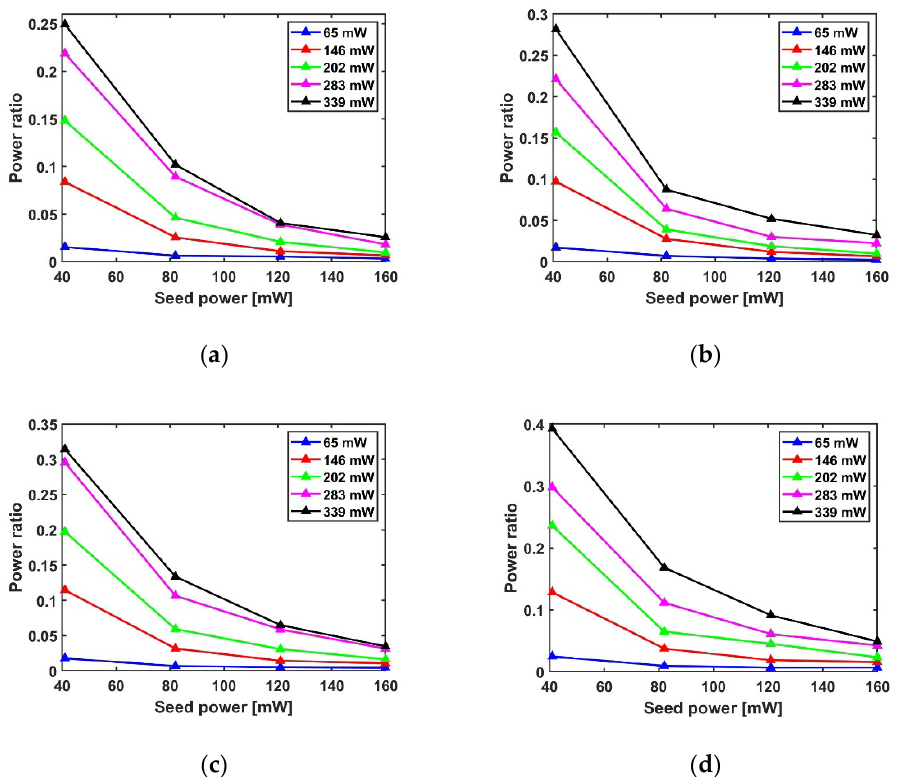
Figure 7. The variation in the power ratio of in-band ASE to signal power with the seed power corresponding to various active fiber lengths. Active fiber length: ( a ) 1.1 m; ( b ) 1.2 m; ( c ) 1.3 m; ( d ) 1.4 m.